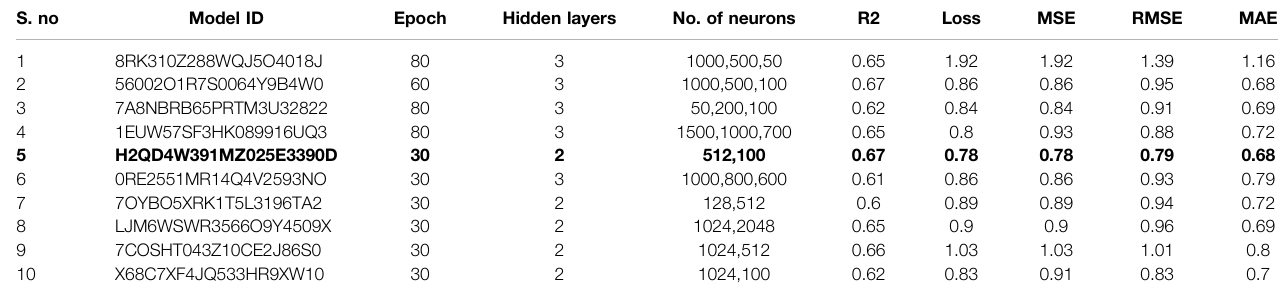
TABLE 1 | Manual optimization of hyperparameters to select the best deep learning model.